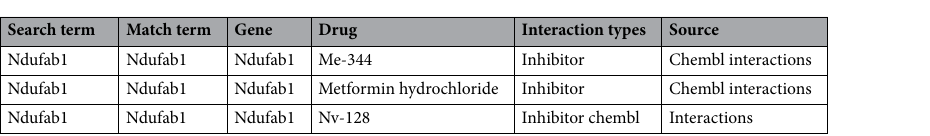
Table 1. Drug-gene interactions in the XGB